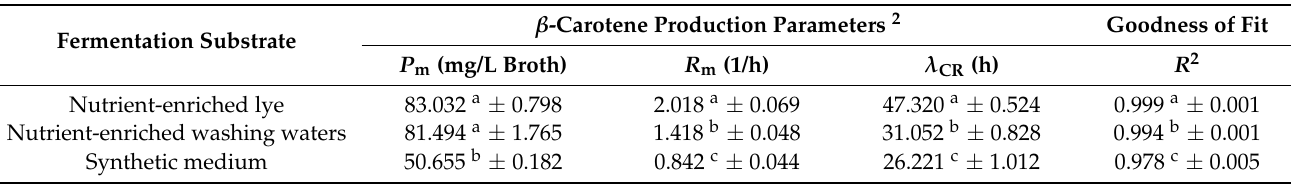
Table 4. β -Carotene production kinetic parameters (modified Logistic model) during B. trispora growth in non-sterile lye and washing waters after enrichment with nutrients as well as in synthetic medium (fermentation time: 6 days) 1 .